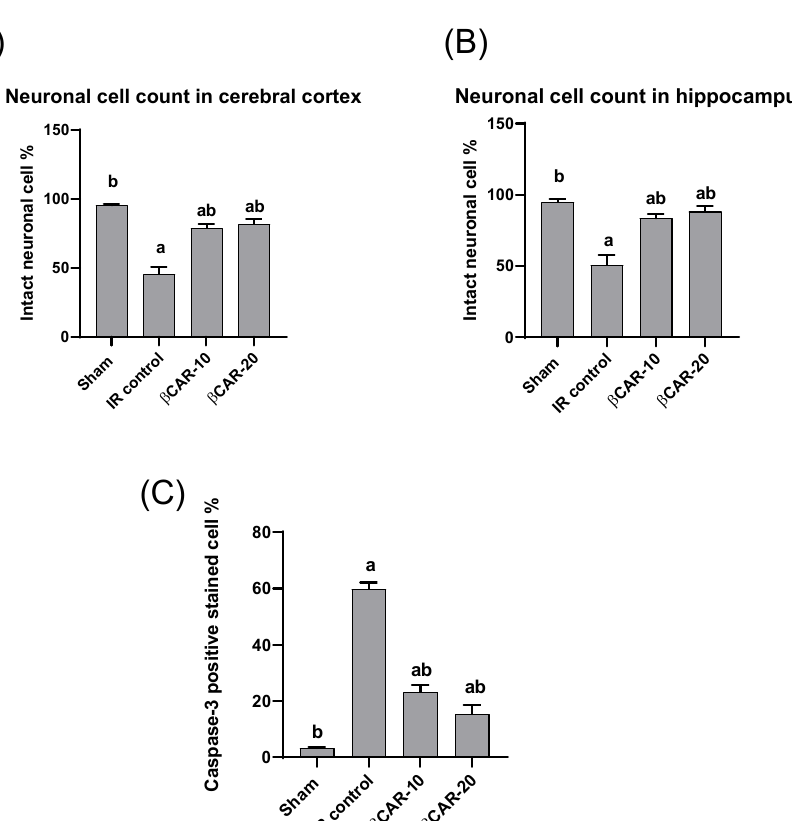
Figure 7. Effect of beta -carotene on neuronal cell count and caspase-3 protein expression. ( A , B ) The bar chart represents the percentage of intact neuronal cells in the cerebral cortex and hippocampus, respectively. ( C ) The bar chart represents the percentage of caspase-3 immunopositive cell in the cerebral cortex. All values are expressed as mean ± SE ( n = 6). a, b denotes significant difference at p ≤ 0.05 against sham and I/R control groups, respectively.